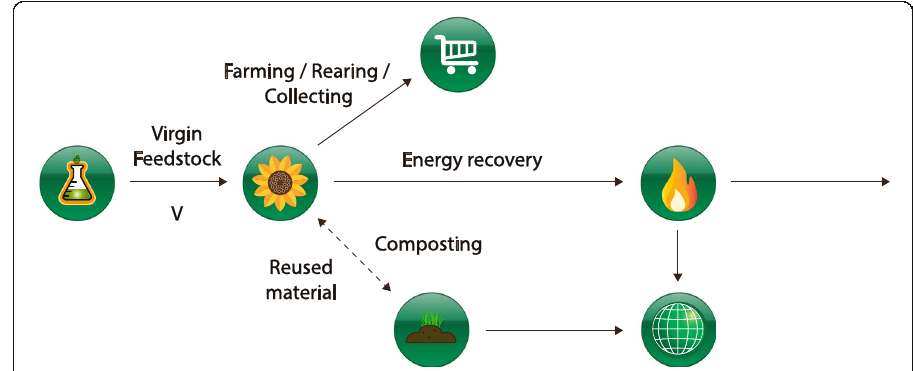
Fig. 2 Modified MCI, a scheme (source: our